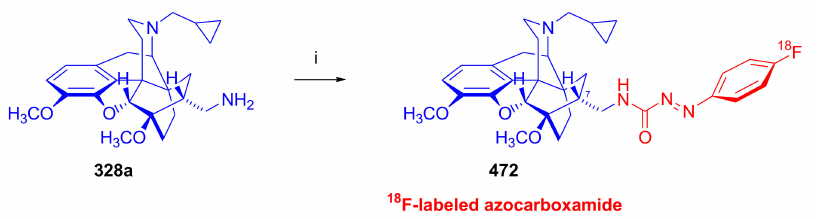
Figure 116. Synthesis of 18 F-labeled buprenorphine-derived azocarboxamide. Reagents and conditions :